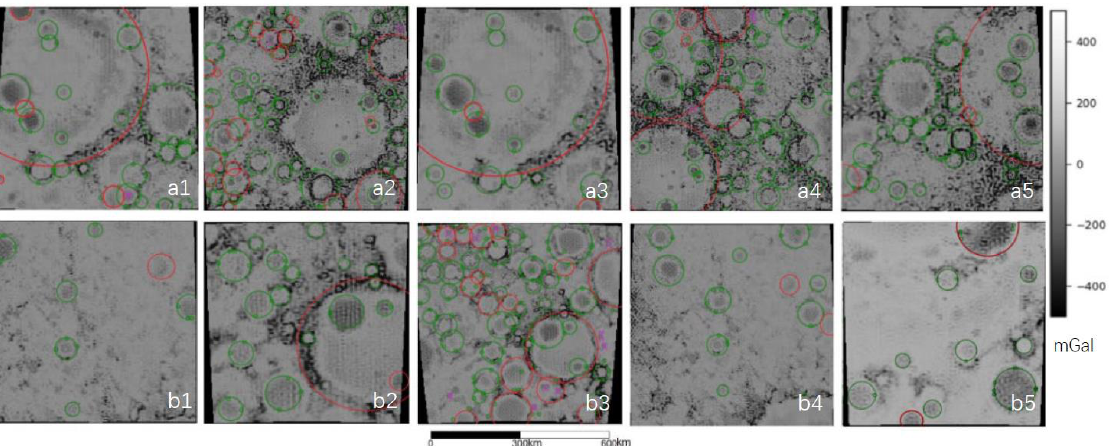
Figure 8. Schematic diagram of model testing results of crater identification. Note: The first row is clipped in the training data set (( a1 – a5 ) mean different areas in the training data set), and the second row is clipped in the areas not touched by the model (( b1 – b5 ) mean different areas outside the training data set area). The green circle represents True Positive, the red circle represents False Negative and the purple X represents False Positive.